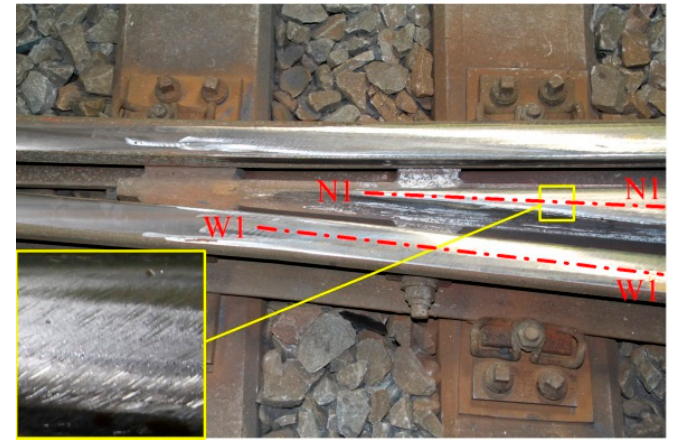
Figure 11. Repaired crossing profile with a magnified image of grinding marks. The degraded crossing was repaired through a grinding-welding-grinding process: first, rail surface damages were removed via grinding; second, hollow regions were filled by welding material; last, the rails were ground again to shape the profile.